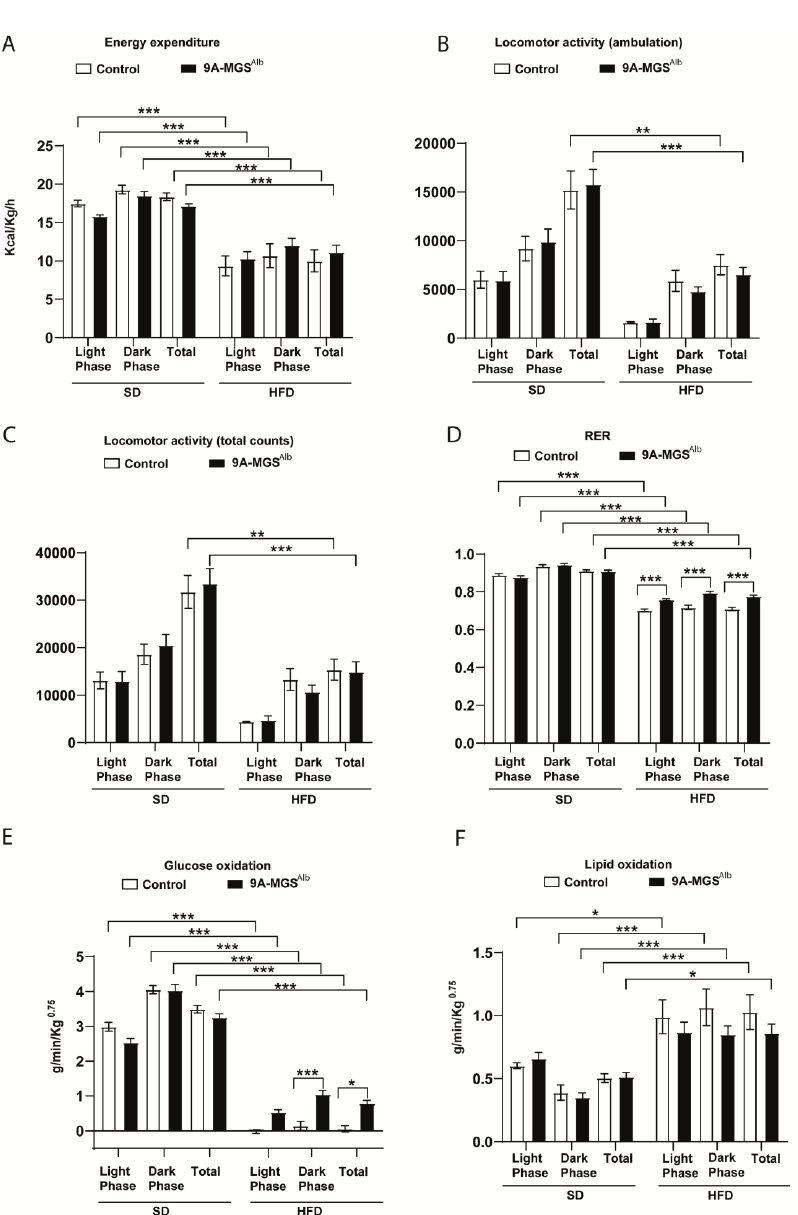
Figure 3. ( A ) Energy expenditure in control and 9A-MGS Alb mice fed an SD and an HFD. ( B ) Locomotor activity (ambulation) in control and 9A-MGS Alb animals fed an SD and an HFD. ( C ) Locomotor activity (total counts) in control and 9A-MGS Alb mice fed an SD and an HFD. ( D ) Respiratory exchange ratio (RER) in control and 9A-MGS Alb mice fed an SD and an HFD. ( E ) Glucose oxidation in control and 9A-MGS Alb mice fed an SD and an HFD. ( F ) Lipid oxidation in control and 9A-MGS Alb mice fed an SD and an HFD. Data are mean ± SEM. n = 4 – 7/group. * p < 0.05, ** p < 0.01, *** p < 0.001.